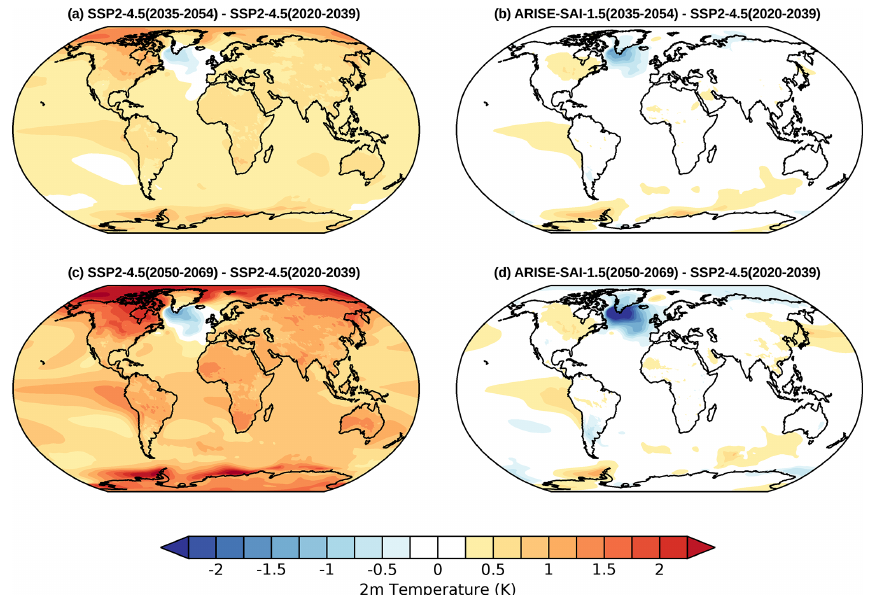
Figure 4. Ensemble and annual mean surface (2m) temperature differences between (a) SSP2–4.5 (2035–2054) and SSP2–4.5 (2020–2039), (b) ARISE-SAI-1.5 (2035–2054) and SSP2–4.5 (2020–2039), (c) SSP2–4.5 (2050–2069) and SSP2–4.5 (2020–2039), and (d) ARISE-SAI- 1.5 (2050–2069) and SSP2–4.5 (2020–2039). Gray shading indicates regions where the differences are not statistically significant at the 95% level using a two-sided Student’s t